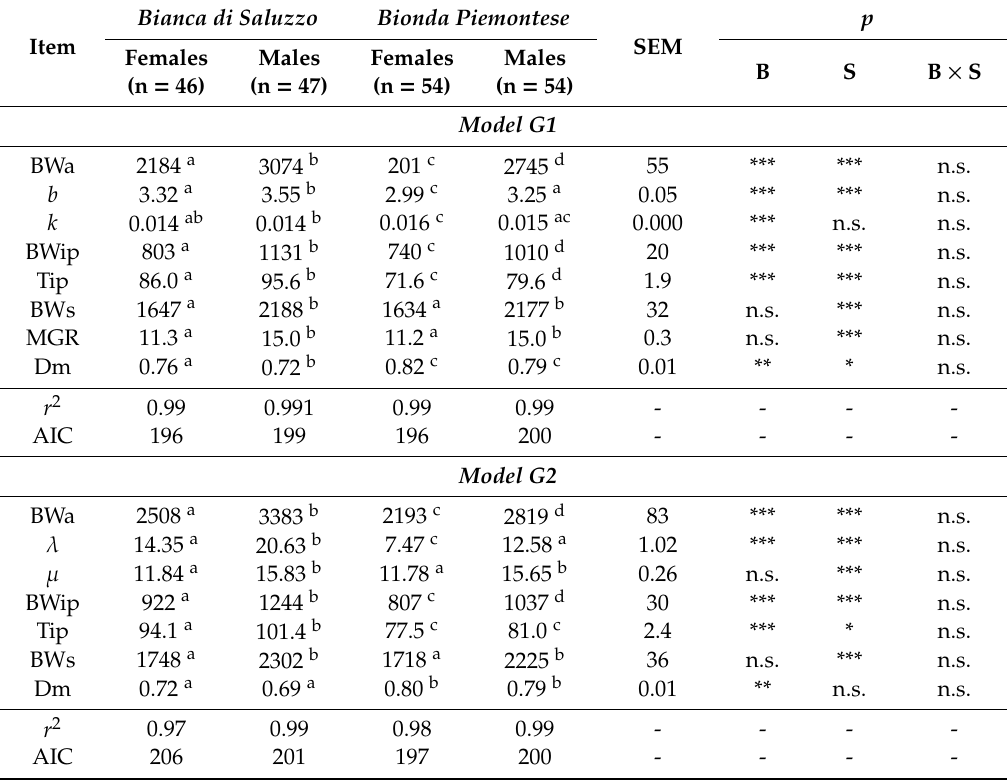
Table 2. Growth curve parameters of the two forms of Gompertz model (G1 and G2) estimated on the males and females of Bianca di Saluzzo and Bionda Piemontese chicken